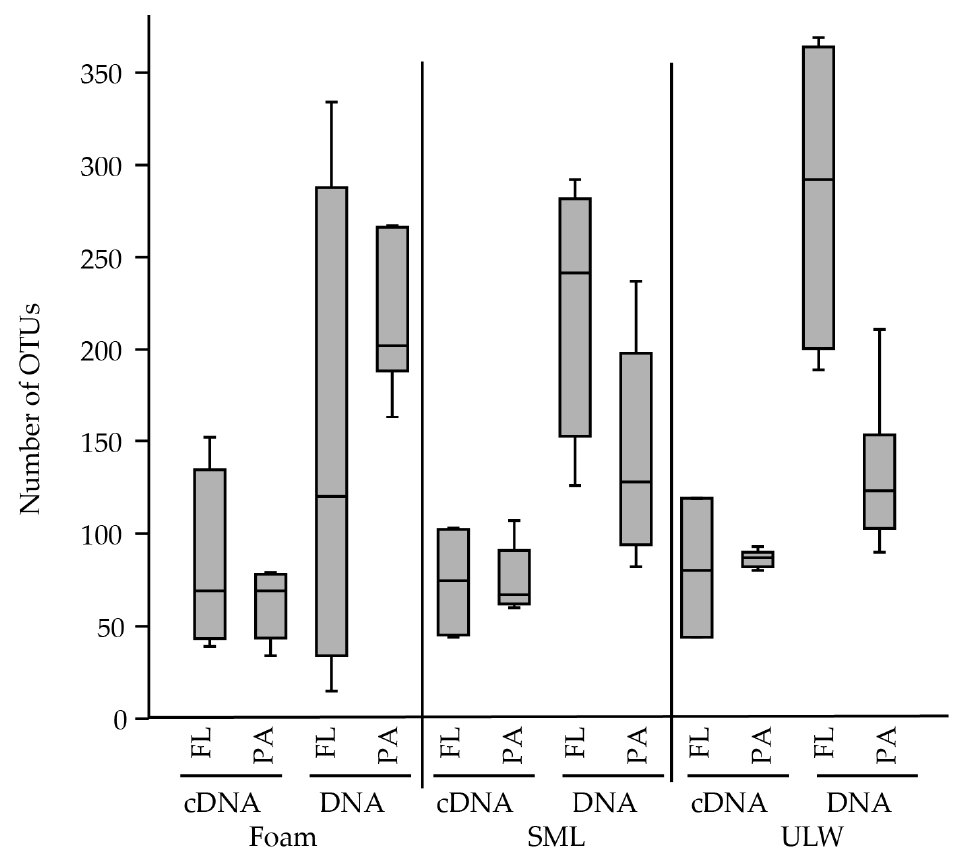
Figure 2. Median of patescibacterial OTUs per habitat, i.e., foam, sea-surface microlayer (SML) and underlying-water (ULW). Samples were further divided into free-living (FL) and particle-associated (PA).